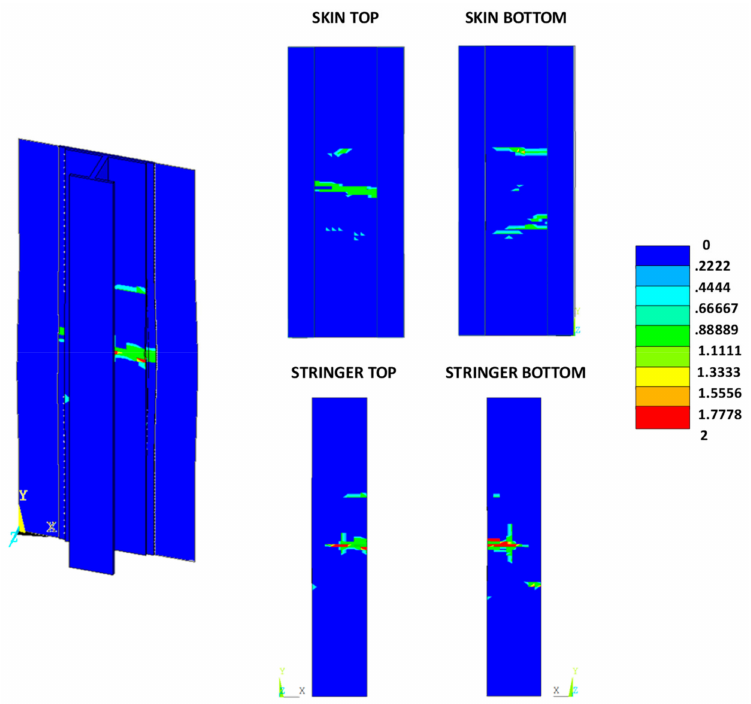
Figure 18. Damage status: material system with high sensitivity to fibre bridging.